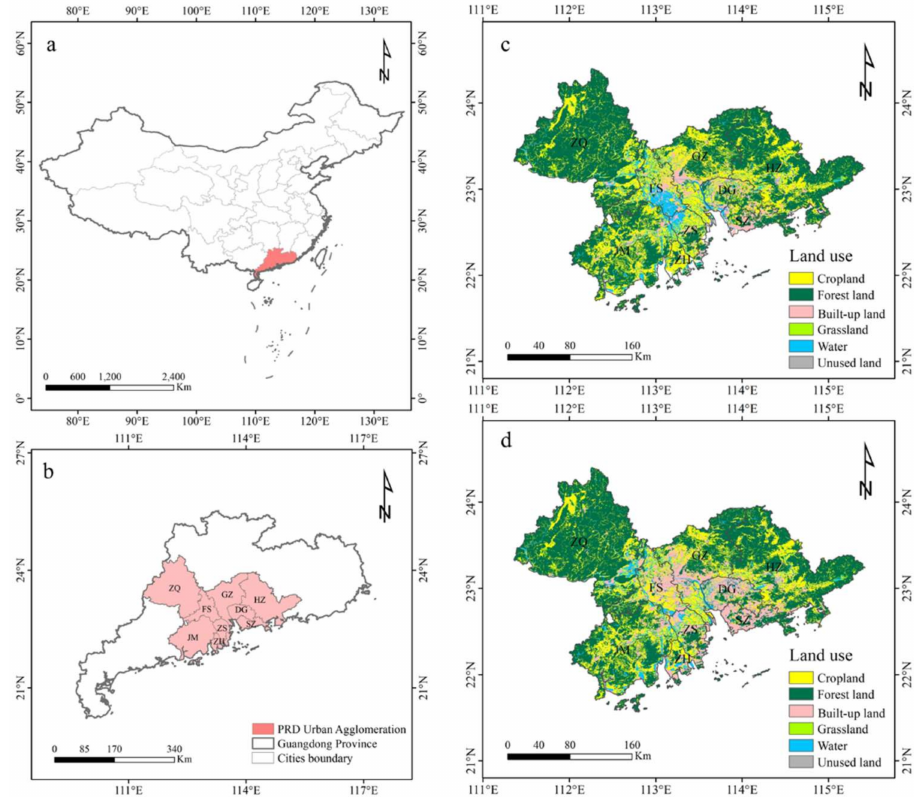
Figure 1. The study area of the Pearl River Delta (PRD) urban agglomeration: ( a ) Guangdong Province in China; ( b ) PRD urban agglomeration in Guangdong Province; ( c ) Land-use of PRD urban agglomeration in 2000; and ( d ) Land-use of PRD urban agglomeration in 2018. DG: Dongguan, FS: Foshan, GZ: Guangzhou, HZ: Huizhou, JM: Jiangmen, SZ: Shenzhen, ZH: Zhuhai, ZQ: Zhaoqing, ZS: